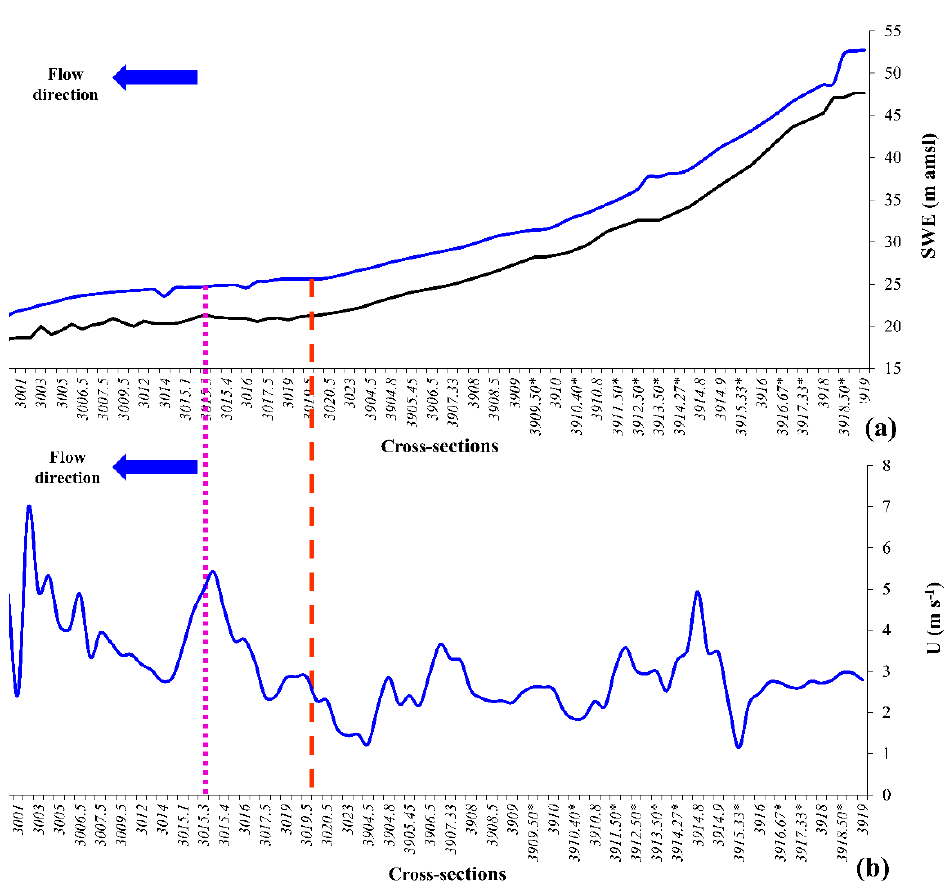
Figure 8. ( a ) Surface Water Elevation SWE (m a.m.s.l.) and ( b ) Flow average velocities U (m s − 1 ) at Morra Creek cross-sections resulting from the 1D unsteady simulation. The continuous black line represents the Morra Creek bed elevation. The blue arrow indicates the flow direction, while the orange dashed lines and the purple dotted lines respectively indicate the locations of “Bridge A” and “Bridge B” cross-sections. The * in the figure is just due to the software output visualization.